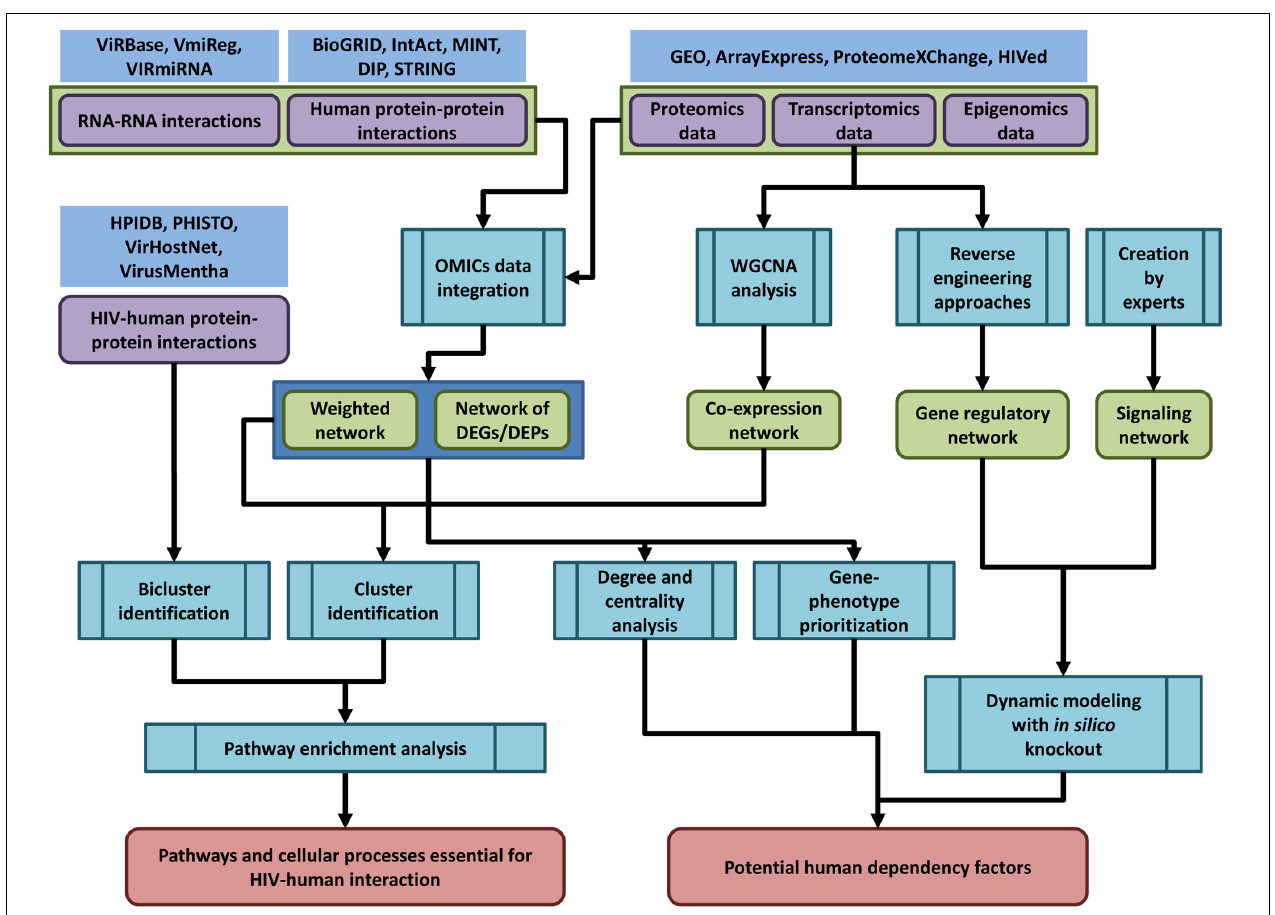
FIGURE 2 | The general pipeline of network-based analysis of HIV-related OMICs data. Public databases provide access to OMICs data on human and HIV-human protein-protein interactions (HPIDB, PHISTO, VirHostNet, VirusMentha, and others, see Table 1 and Supplementary Table S1 ), interactions between human and viral coding/non-coding RNAs (ViRBase, VmiReg, VIRmiRNA databases, Table 3 and Supplementary Table S2 ), transcriptomics, proteomics and epigenomics data (GEO, ArrayExpress, ProteomeXChange, HIVed databases, Supplementary Tables S3 – S6 ) (nodes of purple color in the figure). The HIV-related OMICs data can be used to create context-specific protein-protein interaction networks, co-expression, gene regulatory and signaling networks (nodes of green color in the figure). The context-specific networks can be constructed by weighting protein–protein interactions using transcriptomics, proteomics or epigenomics data, or by taking into account only DEG/proteins (DEGs/DEPs). Co-expression networks can be created using transcriptomics data and weighted gene correlation network analysis (WGCNA). Gene regulatory networks can be inferred from transcriptomics data using reverse engineering approaches, whereas signaling networks are usually manually created by experts based on a great deal of information regarding the protein interactions, post-translational modifications, and other data types. The created networks can be used for different types of analysis (nodes of blue color in the figure): (1) identification of dense communities in human protein-protein interaction and co-expression networks (clusters or modules), or in HIV-human interaction networks (biclusters). The pathway enrichment analysis applied to clusters and biclusters allows identifying pathways and cellular processes, which are essential for HIV-human interaction; (2) degree and centrality analysis, gene phenotype prioritization analysis, as well as dynamic modeling with in silico gene knockout allows identifying proteins, which are the most essential for HIV-human interaction (host dependency factors), and can be considered as potential targets for new anti-HIV therapeutic